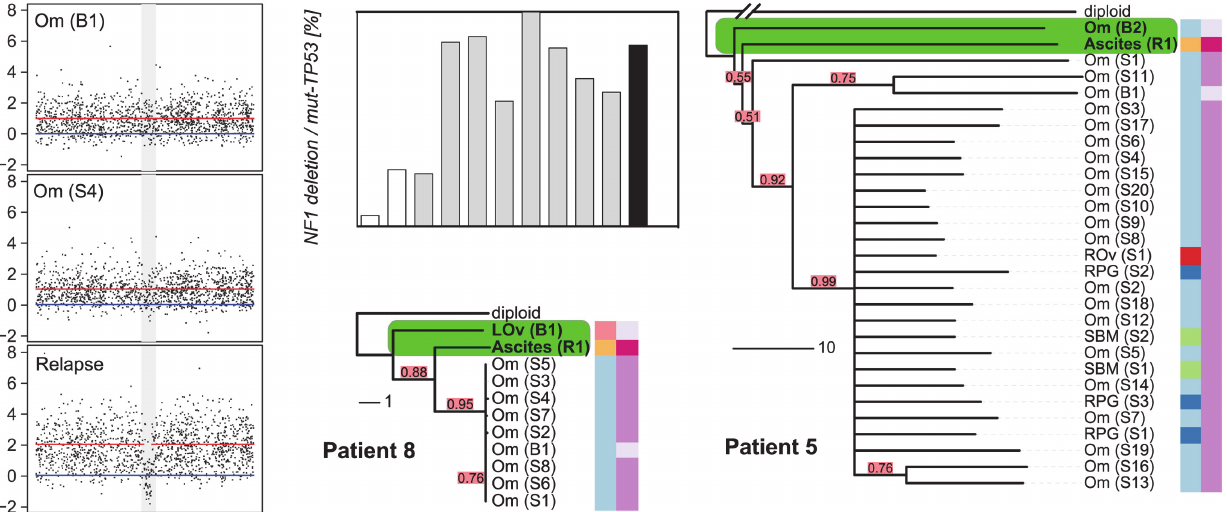
Fig 4. Relapse is an early diverged clonal expansion of a low-prevalence subclone of pre-treatment disease. Array copy number profiles (left) from patient 8 detected a focal NF1 deletion in the relapsed ascites sample that was not observed in the pre-chemotherapy or interval debulking samples. The bar plot shows the results of digital PCR for the NF1 breakpoint from pre-chemotherapy (white bars), interval debulking (grey bars), and relapsed ascites (black) samples. Phylogenetic trees for patients 8 and 5 are shown. The relapsed clonal population for each case is placed next to the pre-chemotherapy biopsy sample, indicating early branching events from the diploid. The length of each branch indicates the degree of divergence. Colour coding and sample identifiers are as for Fig. 3. LOv, left ovary; Om, omentum; SBM, small bowel mesentery; RPG, right paracolic